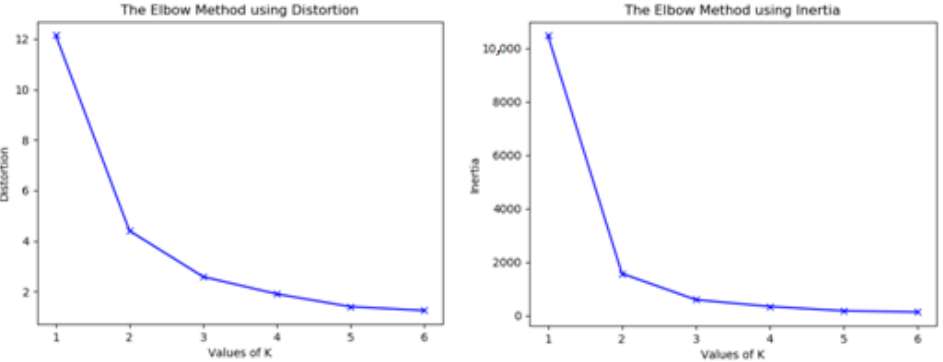
Figure 11. Elbow Method results using Distortion (on the left ) and Inertia (on the right